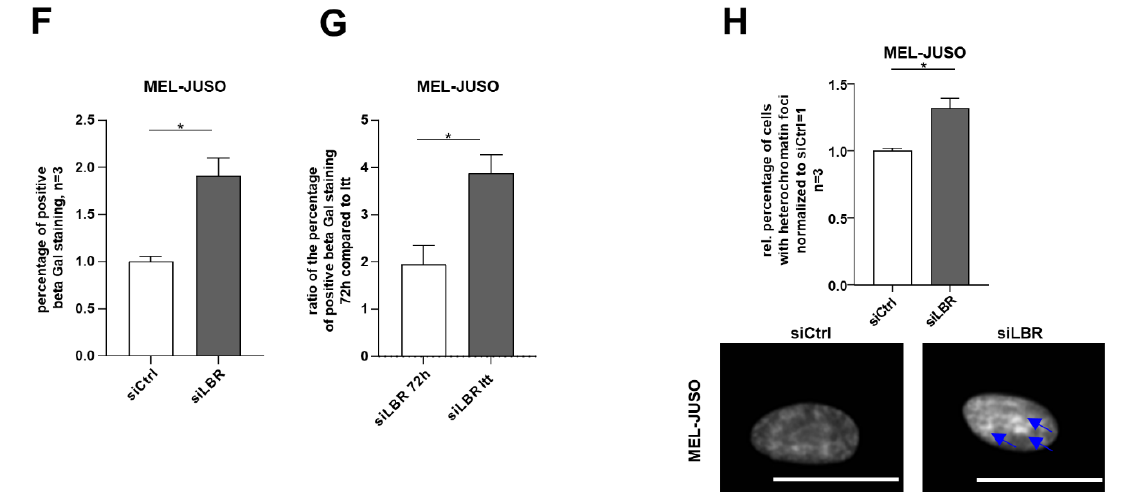
Figure 6. ( A ) Beta-Gal staining of MEL-JUSO transfected with siLBR and siCtrl for 72 h as senescence detection (Student’s t -test). ( B ) Immunofluorescence staining of the promyelocytic leukaemia protein (PML) expression in MEL-JUSO treated with siLBR and siCtrl for 72 h as senescence detection (Student’s t -test). ( C ) Flow cytometry with the fluorescent dye propidium iodide for cell cycle staining. MEL-JUSO treated with siLBR an siCtrl for 72 h (Student’s t -test). ( D ) LBR expression analyzed by qRT-PCR in the established senescence model using mock- and BRAF V600E lentiviral- transduced NHEMs, as well as MEL-JUSO cells treated with the cytostatic drug etoposide compared to the control (Student’s t -test). ( E ) Epiquik Chromatin Accessibility Assay to verify the chromatin status in NHEMs treated with mock and Braf V600E (established senescence model) and in siLBR long-term-treated MEL-JUSO compared to siCtrl. Normalized log10 %FE for siCtrl 72 h and siCtrl LTT, to exclude an effect of the transfection process by siCtrl over a longer period. ( F ) Beta-Gal staining of MEL-JUSO long-term-transfected with siLBR as senescence detection (Student’s t -test). ( G ) Showing the ratio of the positive β -Gal staining of MEL-JUSO for transfection with siLBR 72 h in comparison to long-term transfection. The percentage of beta-gal-positive stained melanoma cells of the respective siCtrl was included in the ratio between siLBR 72 h and siLBR LTT (Student’s t -test). ( H ) The melanoma cell line MEL-JUSO was long-term-transfected for three months with siLBR and siCtrl, respectively. Chromatin condensation (DAPI) was analysed and quantified (Student’s t -test). Enlarged images show representative chromatin foci and visible SAHF marked with blue arrows. Scale bars equal 20 µ m. Bars represent the means ± SEM (* = p ≤